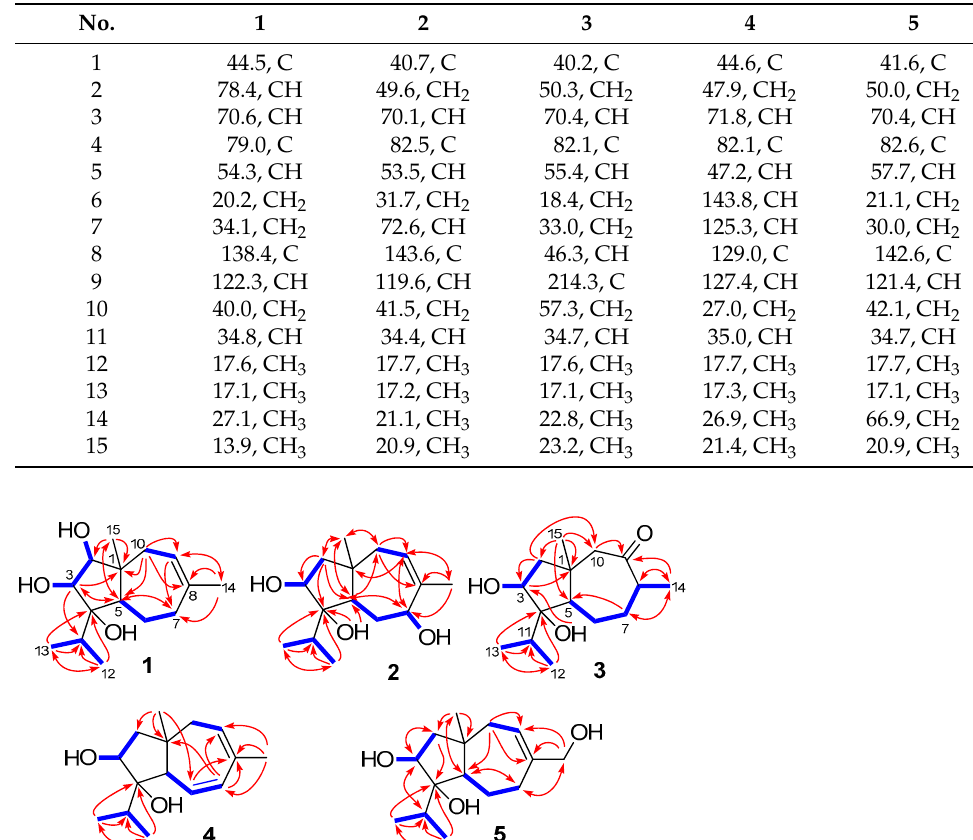
Table 2. 13 C NMR Data for Compounds 1 – 5 in DMSO- d 6 (125 MHz).